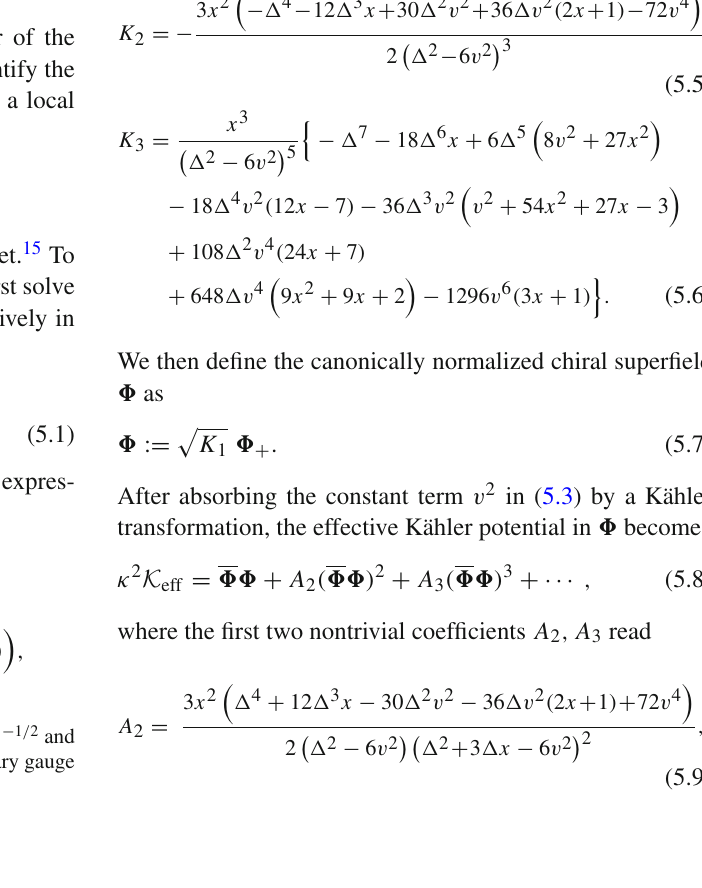
Table 1, (cid:2) + transforms under U ( 1 ) m × U ( 1 ) (cid:3) with charge